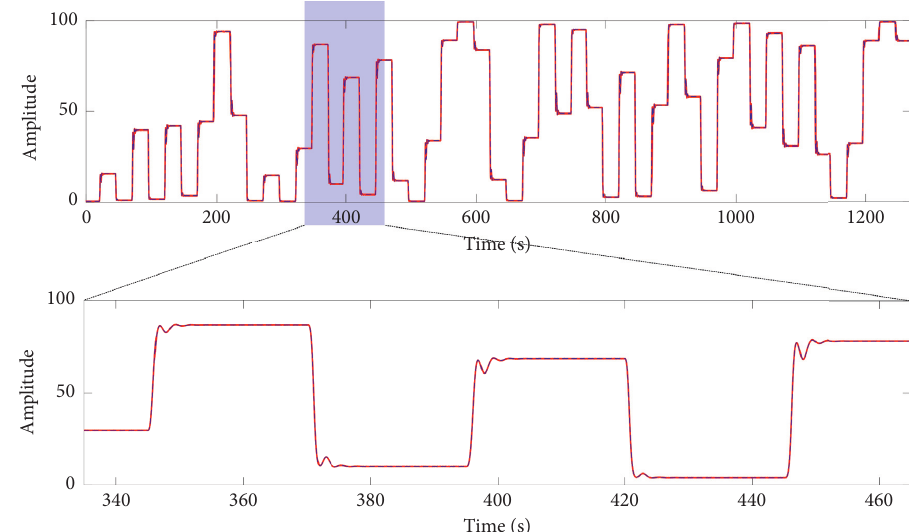
Figure 11: Validation results for numerical example 1: real output (red solid line) and model output (blue dashed line).